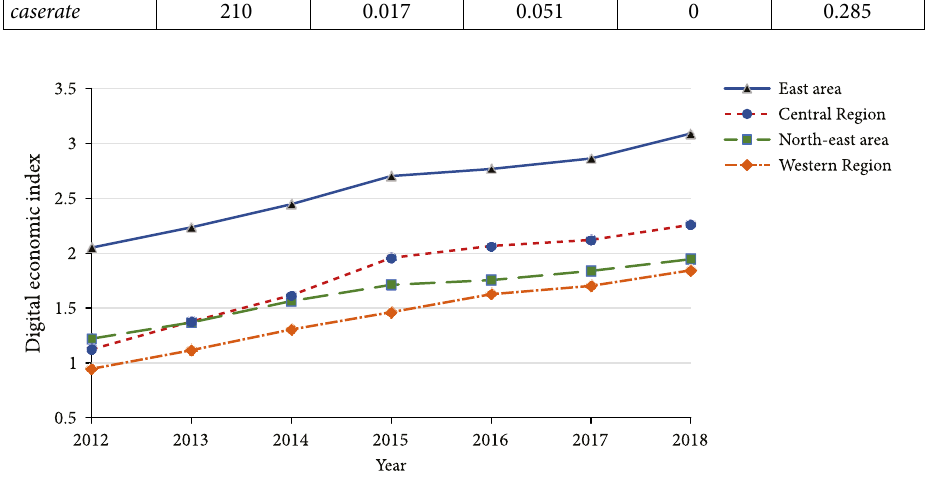
Figure 1. The trend of digital economy growth in different